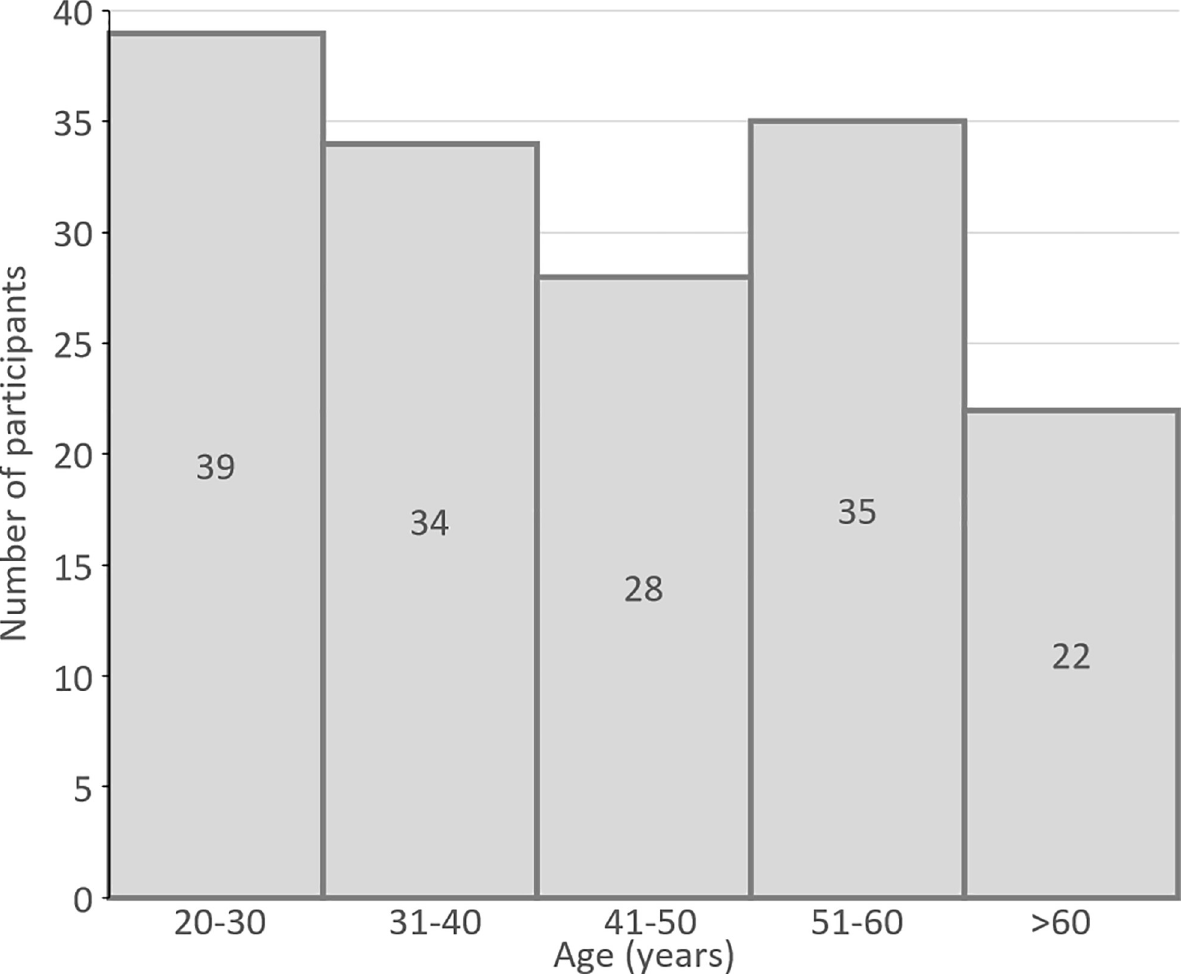
Fig 2. Histogram showing the age distribution of individuals who participated in the study. The numbers inside the bars represent the number of individuals in each decade, with the only exception being the last bar which shows individuals greater than 60 years of age.